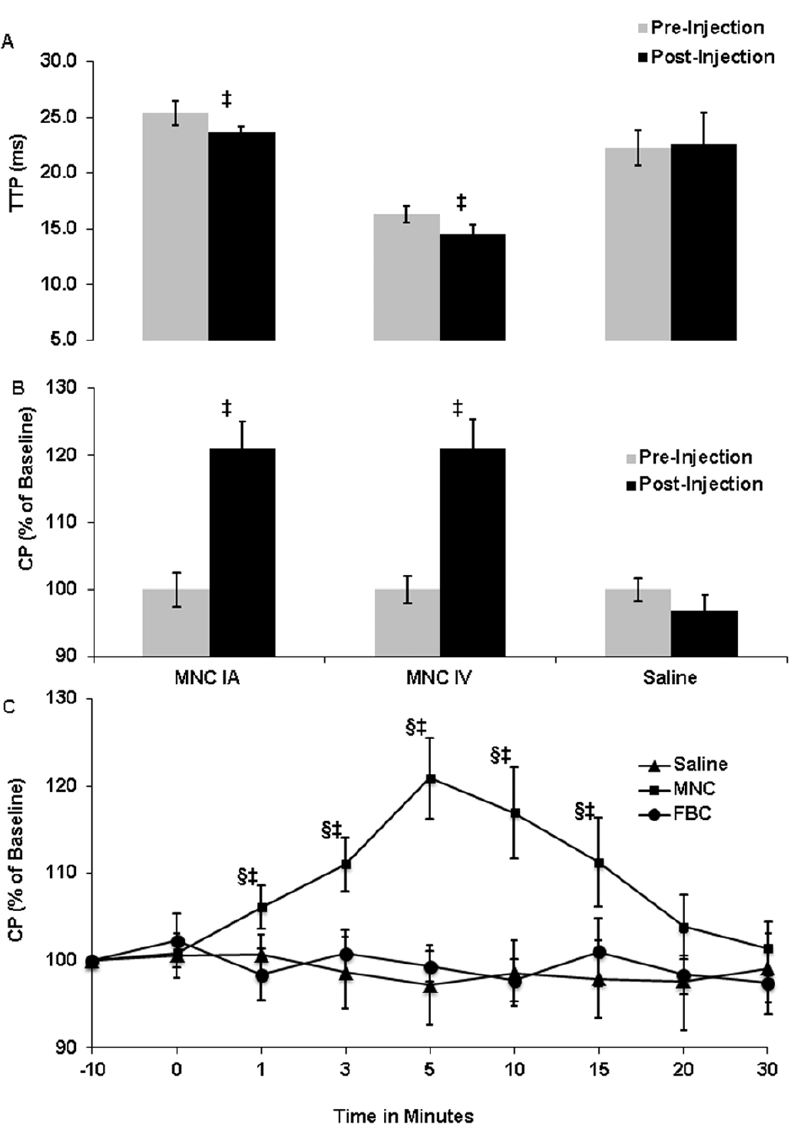
Figure 1. Changes in Cerebral perfusion. (A) Perfusion weighted imaging was performed in animals receiving MNC or saline at 24 hrs after MCA occlusion. There was a significant decrease ( { p , 0.05) in the mean TTP in the peri-infarct region at 5 minutes after MNC infusion via IA or IV routes of delivery. There was no significant change in TTP in the saline group before and after injection. N=4 per group. (B) Cerebral perfusion (CP) was monitored with Laser Doppler flowmetry over the peri-infarct area of animals administered MNCs (10 million cells) or saline at 24 hrs after MCA occlusion. CP was expressed after injection as a percentage compared with the baseline pre-injection value. CP increased at 5 minutes after MNC injection. There was no significant change in CP in the saline treated group. N=6 per group. (C): Time course of changes in cerebral perfusion after IV injection of MNCs (10 million cells), FBCs (10 million), or saline. { p , 0.05 refers to the MNC group compared to the saline group and 1 p , 0.05 refers to the MNC group compared with the FBC group. There was significant elevation of CP after MNC infusion at 1, 3, 5, 10 and 15 minutes. There was no significant change in CP in the saline or FBC groups. ‘0’ on x-axis represents the time in minutes, just before the injection. N=6 per group.